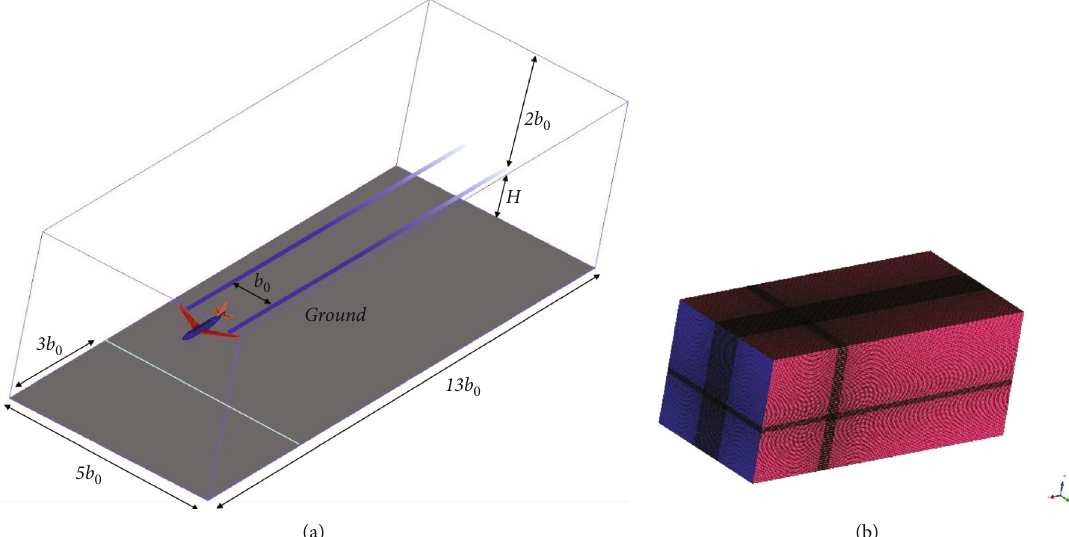
Figure 1: Computational domain and its grid. (a) Schematic diagram of computational domain and (b) computational domain grid.